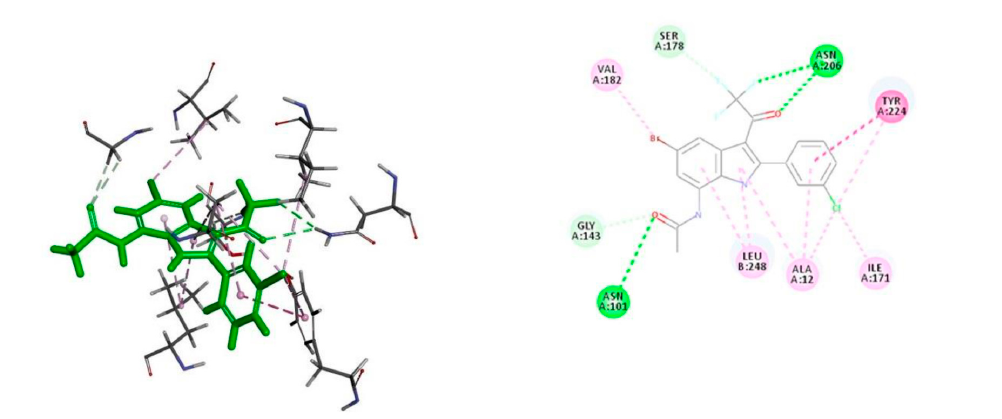
Figure 6. 2D interaction diagrams for the binding of tubulin (PDB code 1TUB) with 2a , 4a and 5g . Residues are annotated with their 3-letter amino acid code The various interactions are annotated by color; alkyl/pi-alkyl (pink), carbon hydrogen bond (light green) and conventional hydrogen